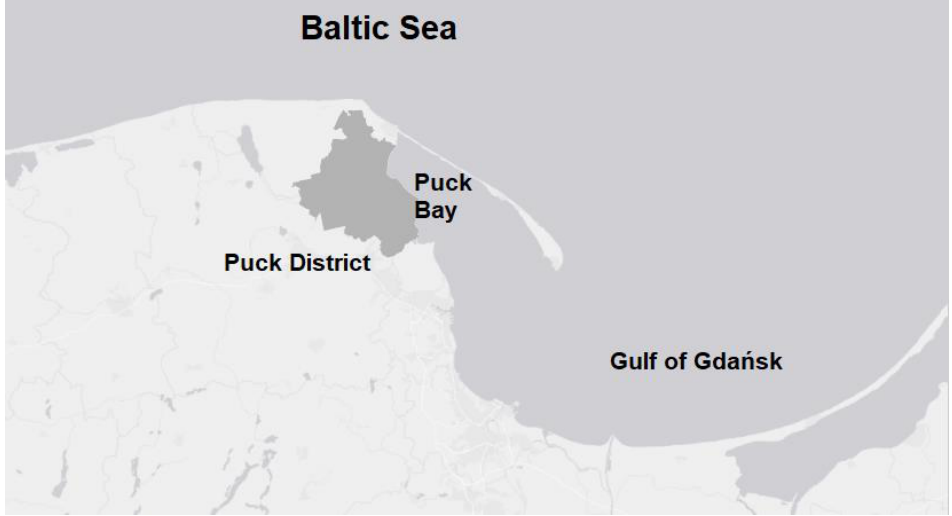
Figure 1. Location of the study area.